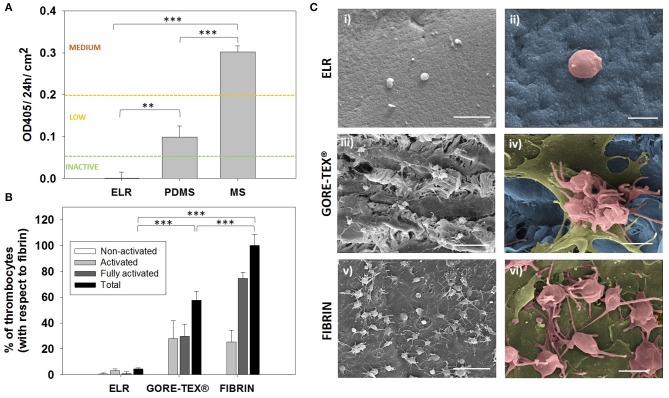
Hemocompatibility assessment. (A) Hemocompatibility of ELR-gels assessed using the C5 complement convertase activity. Control materials used for comparison: medical steel (MS) and polydimethylsiloxane (PDMS). (B) Evaluation of adhered platelets based on SEM images. Results are plotted as the mean of three different experiments ± standard deviation. (C) SEM images of (i,ii) ELR hydrogel, (iii,iv) GORE-TEX®, and (v,vi) fibrin-gel after 1 h in contact with platelet rich plasma. Activated and fully activated platelets were covering fibrin and GORE-TEX® surfaces, while ELR surfaces presented minimal platelet adhesion. In the images ii, iv and vi, the ELR and GORE-TEX® scaffolds were colored in blue, the platelets with a spread morphology in gold and the more rounded platelets in salmon. Scale bars: (i,iii,v): 10 μm; (ii,iv,vi) 2 μm.